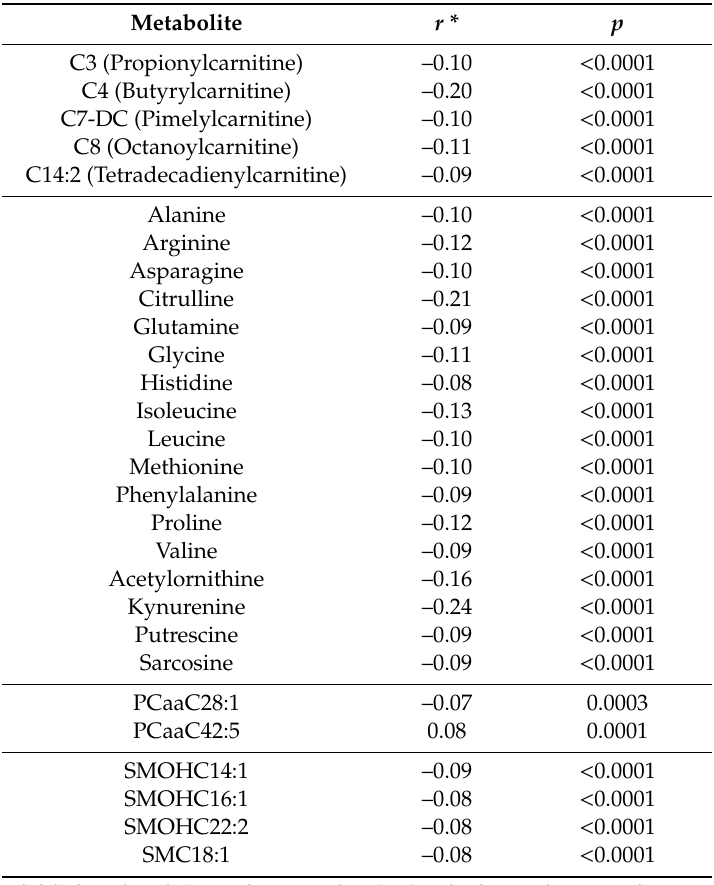
Table 2. Relationship between metabolites and estimated glomerular filtration rate